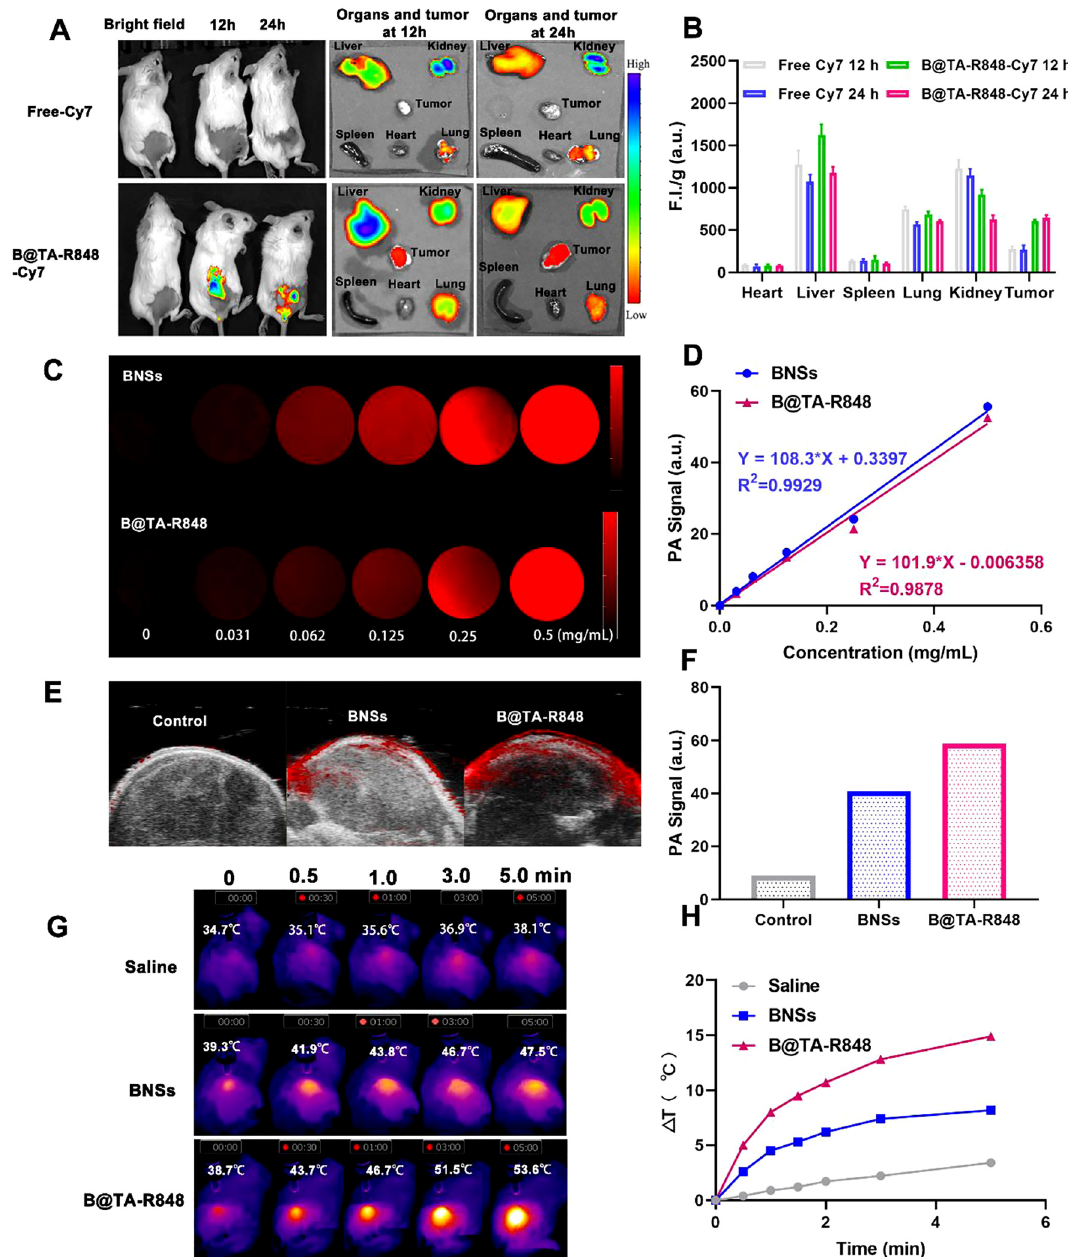
Figure 4: In vivo imaging and biodistribution. (A) Ex vivo fl uorescence images of the tumor at 12 and 24 h post injection and major organs at 12 and 24 h post injection. (B) Semiquantitative biodistribution of free Cy7 or Cy7-labeled B@TA-R848 in BALB/C mice detected by the average fl uorescence intensity of tumors and major organs per gram. (C) In vitro photoacoustic images of BNSs and B@TA-R848 as a function of concentration (0, 0.031, 0.062, 0.125, 0.25, and 0.5 mgmL − 1 ); (D)Photoacoustic valuesof BNSs andB@TA-R848as a functionof concentration(0,0.031, 0.062,0.125,0.25,and0.5 mg mL − 1 ). (E) Photoacoustic images of the tumor site in control, BNSs, and B@TA-R848 groups at 12 h post injection. (F) Quantitative analysis